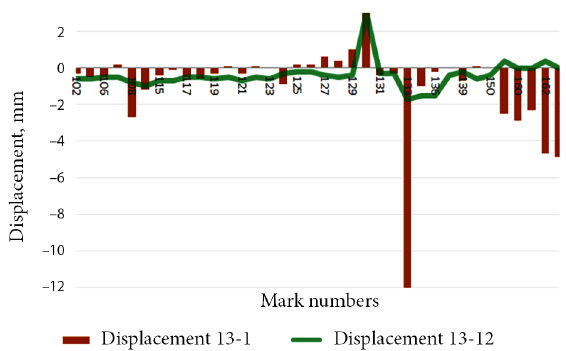
Figure 5. Graph of shift of marks between 13 and 1 cycle, and 13 and 12 cycle of observations on the first floor